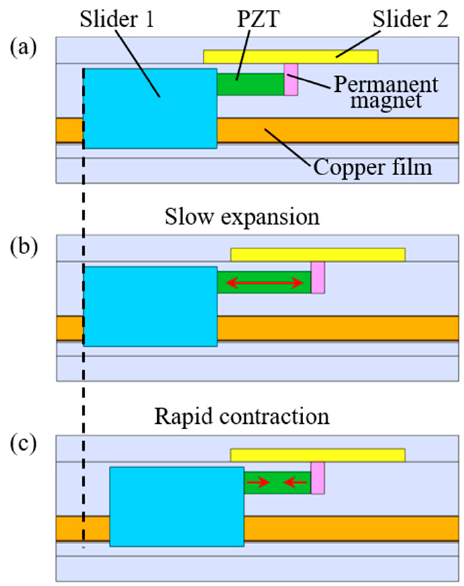
Figure 4. The impact drive mechanism (IDM) mode for positioning the slider 1. ( a ) Initial position of the PZT; ( b ) Slow expansion of the PZT; ( c ) Rapid contraction of the PZT.